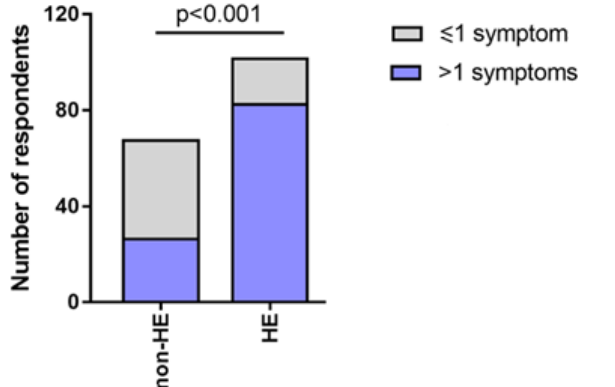
Figure 4. Number of symptoms reported by the HE-study group and the non-HE group immediately after application of the